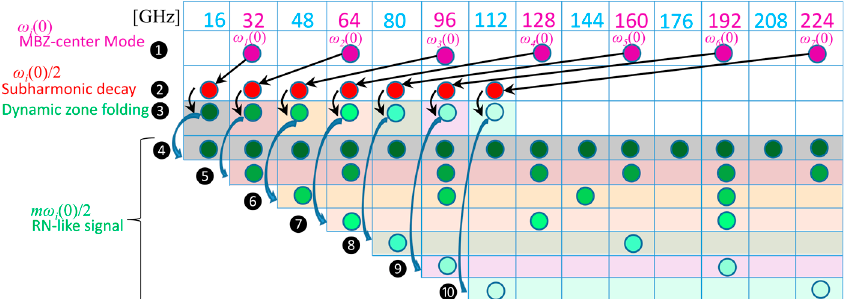
Figure 6. Illustration of MBZ coherent acoustic phonon distribution in the DBR. The plot demonstrates MBZ-center modes ω i (0) distribution, the subharmonic decay of ω i (0)/2 and subsequent new zone folding (MBZ edge is folded onto MBZ center), and the detectable Raman-Nath-like (RN-like) phonon sequences m ω i (0)/2, where m ( m = 1, 2, 3, …) denotes the replicas order of each RN-like sequence and i ( i = 1, 2, 3, …) denotes the order of MBZ center mode. (Here, the phonon bandgaps on MBZ center and edge are ignored for simplicity and values of frequency are approximately regarded as n -times 16 GHz based on calculation, where n = 1, 2, 3, …).